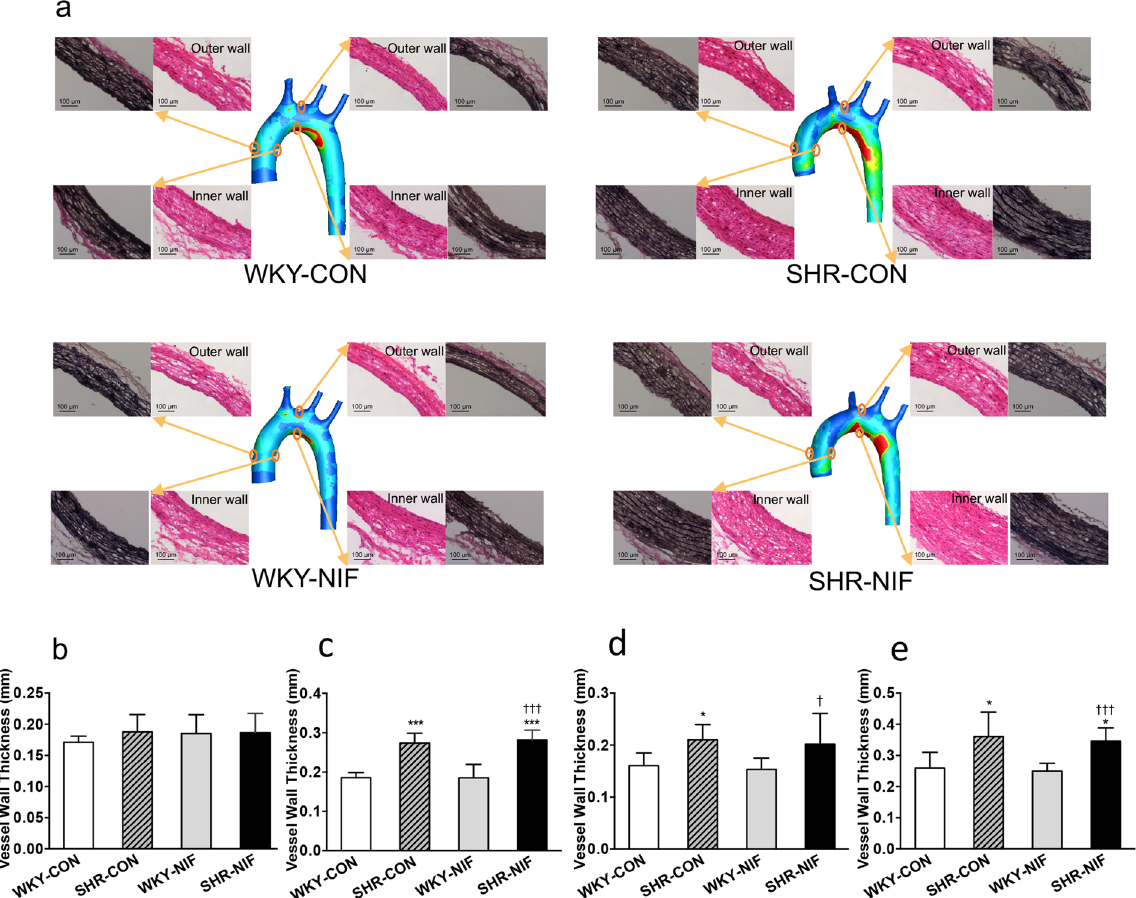
Figure 3. Arterial wall thickening and extensive elastin degradation were demonstrated near the inner wall of the aortic arch and was accompanied by elevated OSI and RRT values in hypertensive and antihypertensive- treated SHRs. ( a ) Histological analysis of cross-sections of the ascending aorta and aortic arch was performed with H&E and VVG staining in the WKY-CON, SHR-CON, WKY-NIF, and SHR-NIF groups. Quantitative analysis of the regional vessel wall thickness is shown in the ( b ) outer wall and ( c ) inner wall of the ascending aorta and the ( d ) outer wall and ( e ) inner wall of the aortic arch. Values are presented as the mean ± SD. (n = 6). * P < 0.05, *** P < 0.001, vs WKY-CON. † P < 0.05, ††† P < 0.001, vs WKY-NIF. CON, control; NIF,